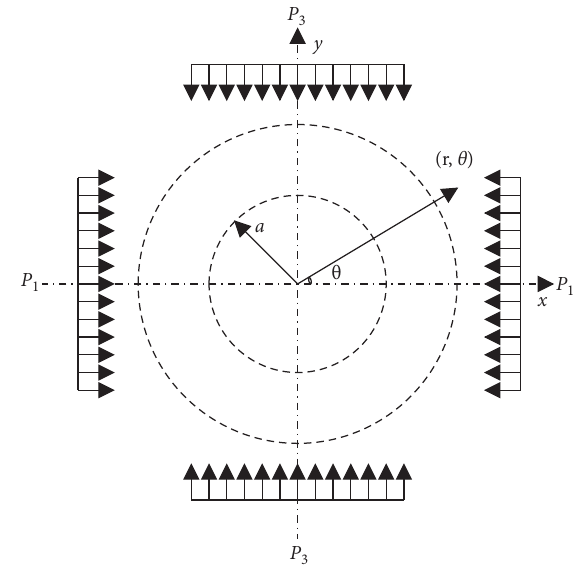
Figure 3: Theoretical calculation of butterfly-shaped plastic zone. P 1 and P 3 are the maximum and minimum principal stress in surrounding rock stress field; a is the radius of circular roadway; R , θ is the polar coordinates of any